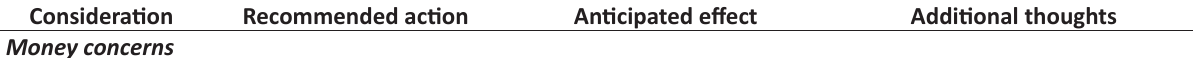
Table 1. How to target your paper for a journal, generate time (e.g., for better work-life balance) by avoiding multiple resubmissions, and improve the publishing landscape at the same